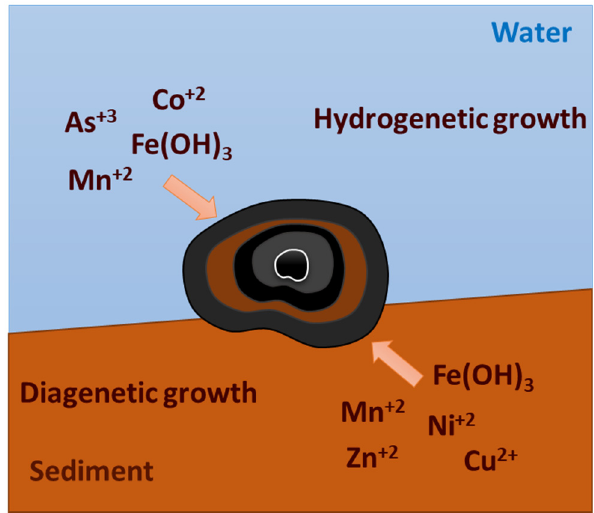
Figure 2. Types of growth of manganese nodules (modified from Marino et al. [24]).